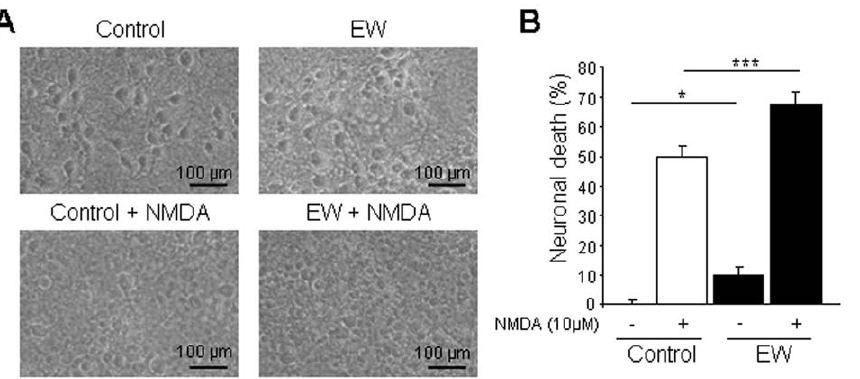
Figure 1. Ethanol withdrawal increases by 40% the sensitivity of neurons to excitotoxic injuries induced by NMDA (10 m M, 24 h) in cultured cortical neurons. (A) Phase-contrast photomicrographs show representative fields in the indicated conditions (Control, neurons not exposed to ethanol; EW, ethanol-withdrawn neurons). (B) Quantification of neuronal death. Values are means 6 SEM (n=17–20 wells/condition; N=5 plates). Data were assessed by ANOVA test followed by Fisher’s PLSD test (* P , 0.05; *** P , 0.001).